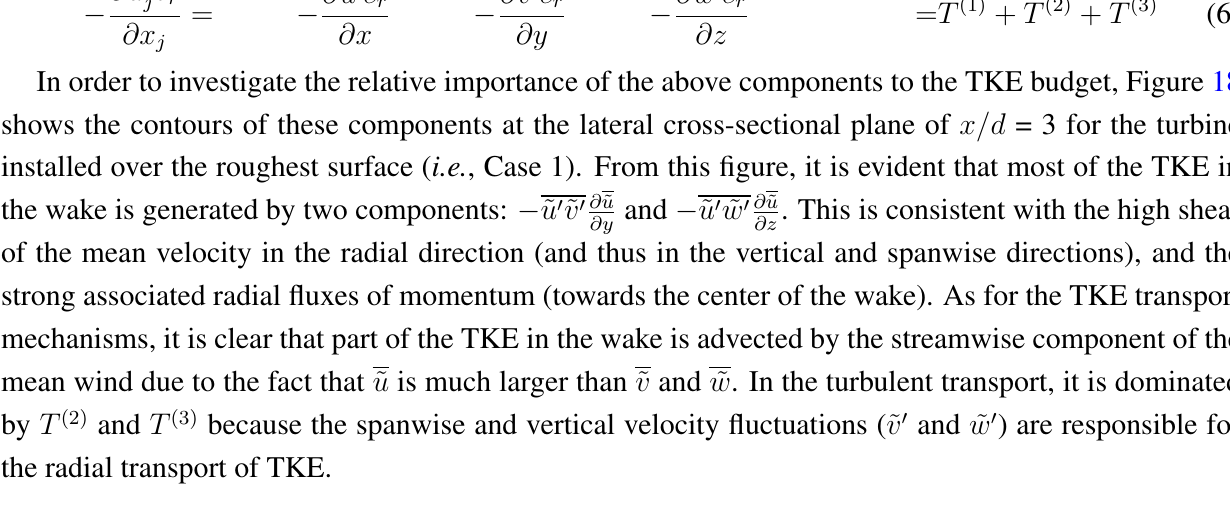
Figure 18. Contours of the components of the TKE budget terms at the lateral cross-sectional plane of x/d = 3 for the turbine installed over the roughest flat surface. ( a ) shear production; ( b ) advection; and ( c ) turbulent